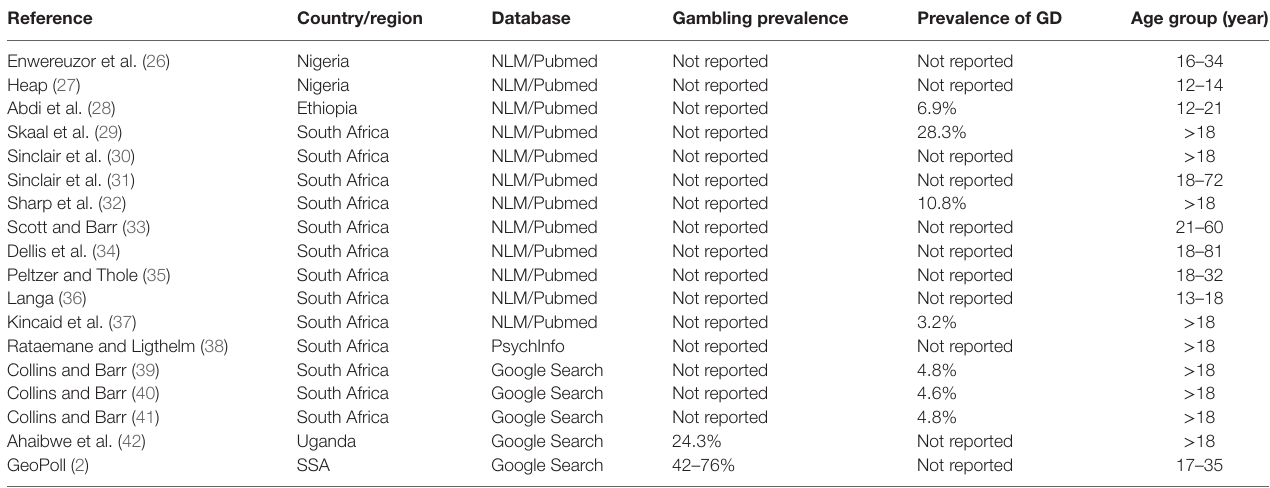
tAble 1 | A list of studies focusing on gambling-related activities and GD in SSA.